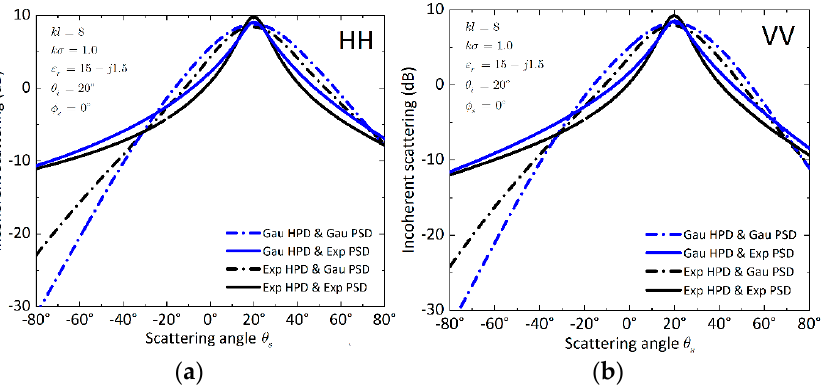
Figure 6. Comparison of bistatic incoherent scattering in an incident plane for four types of surfaces: Gau HPD and Gau PSD, Gau HPD and Exp PSD, Exp HPD and Gau PSD, Exp HPD and Exp PSD. The related parameters are kl = 8, k σ = 1.0, ε r = 15 − j 1.5, θ i = 20 ◦ , φ s = 0 ◦ . ( a ) HH polarization, ( b ) VV polarization.